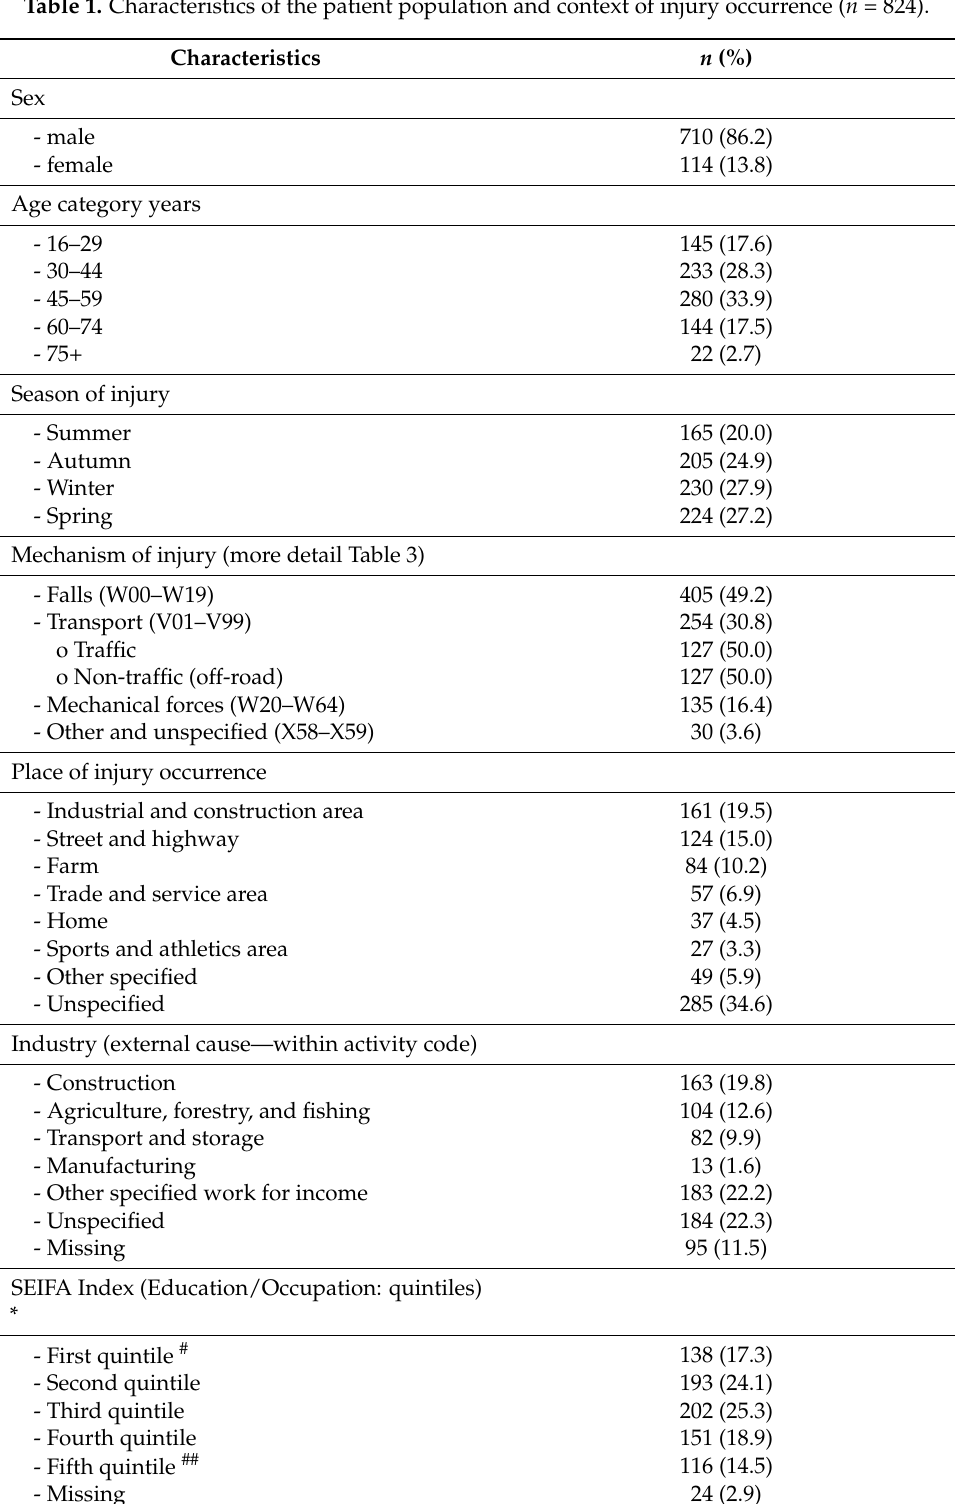
Table 1. Characteristics of the patient population and context of injury occurrence ( n =